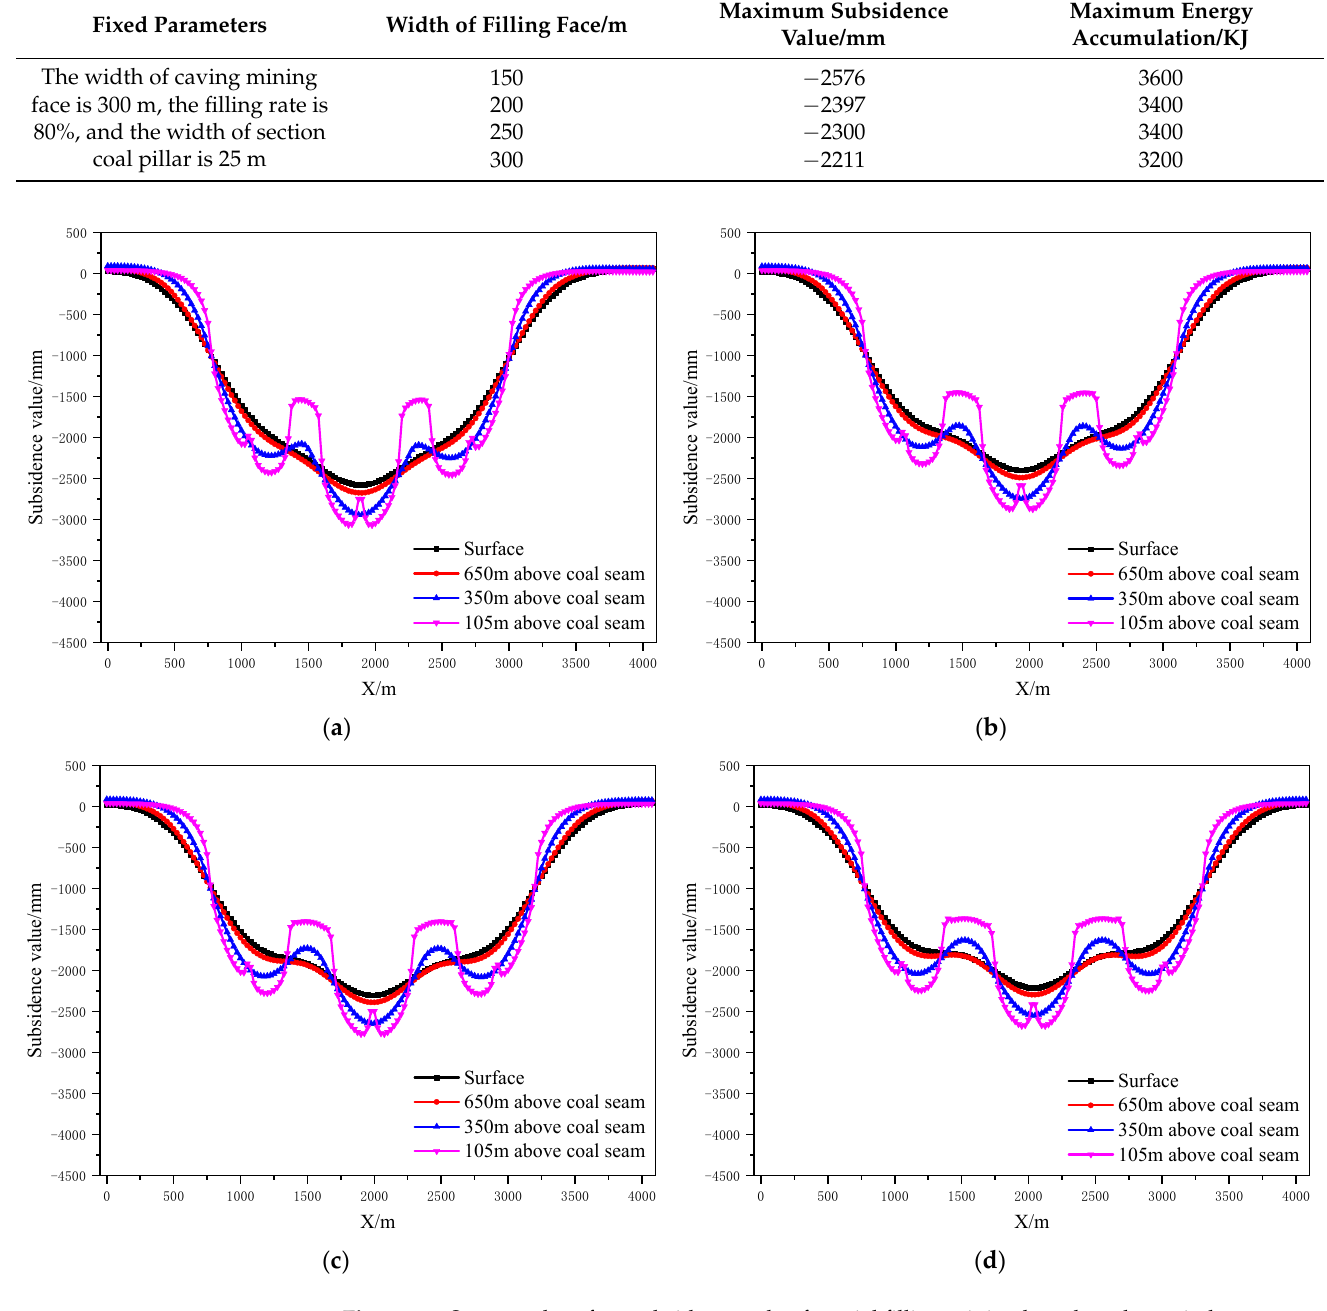
Figure 10. Strata and surface subsidence rule of partial filling mining based on the main key stratum under different filling face scales; ( a ) width of filling face =150 m. ( b ) Width of filling face =200 m. ( c ) Width of filling face =250 m. ( d ) Width of filling face =300 m.